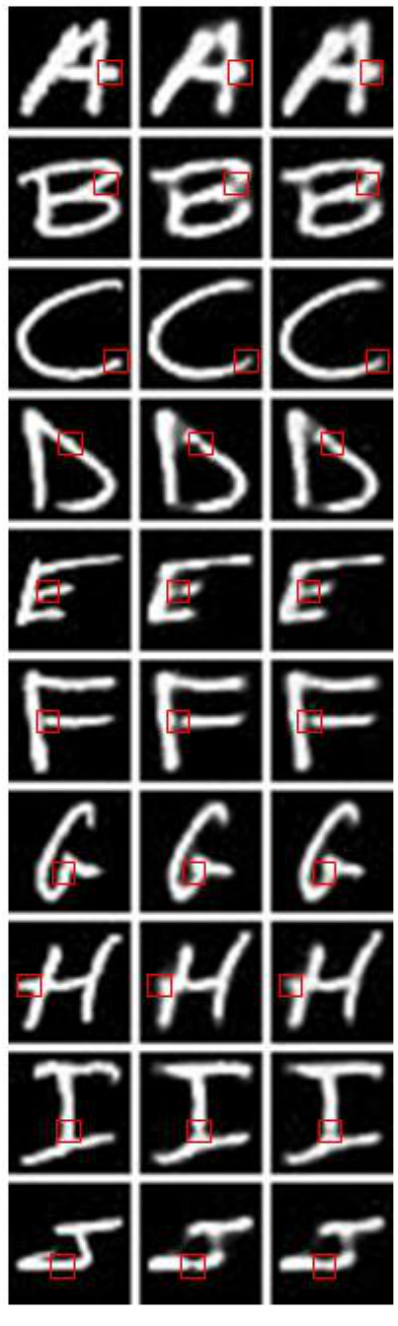
Figure 19. Marked reconstruction images on the EMNIST data set ( big letters ). Similarly, the reconstitution images on the EMNIST data set (big letters) are demon- strated in Figure 18; the marked reconstitution images on the EMNIST data set (big letters) are demonstrated in Figure 19. The rebuilding images on the EMNIST data set (small letters) are displayed in Figure 20; the marked rebuilding images on the EMNIST data set (small letters) are displayed in Figure 21. The reconstruction images on the FMNIST data set are shown in Figure 22; the marked reconstruction images on the FMNIST data set are shown in Figure 23. The recovery images on the MMNIST data set are displayed in Figure 24; the marked recovery images on the MMNIST data set are displayed in Figure